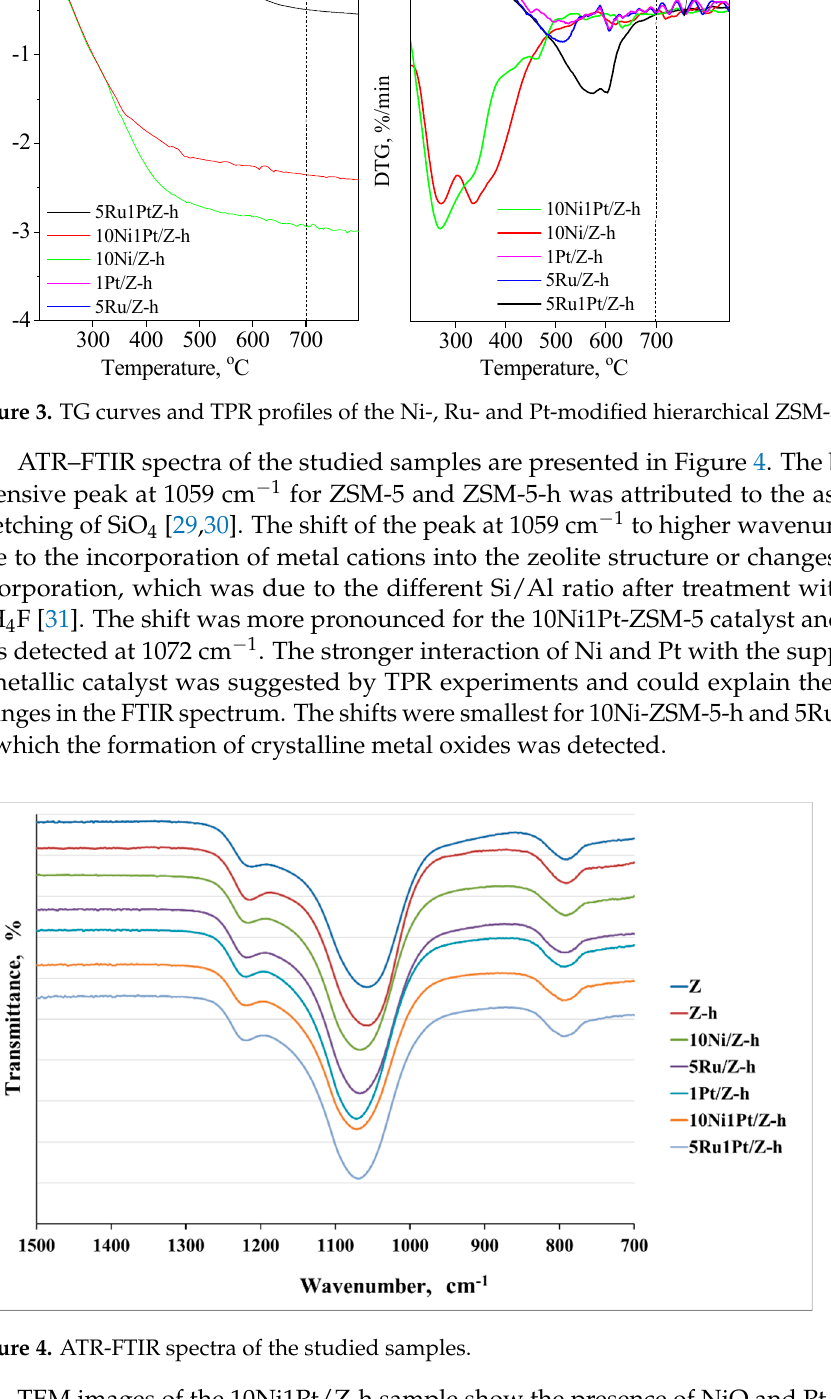
Figure 5. TEM images of 10Ni1Pt/Z-h ( A , B ) and 5Ru1Pt/Z-h ( C , D ) zeolites. 2.1.1. FTIR Spectra of Adsorbed Pyridine The acidic properties of selected catalysts were characterized by FTIR spectroscopy of adsorbed pyridine (Py) in order to compare their Brønsted and Lewis acidity [32]. The FTIR spectra of the investigated samples are presented in Figure 6. The 8a, 8b and 19b ring vibrations ( ν CCN ) of Py yielded adsorption bands in the 1700–1400 cm − 1 frequency region [33]. Py can be coordinated to Lewis acid sites (L-Py) or protonated on Brønsted acid centers (B-Py) of zeolites. B-Py showed a band pair at approximately 1545/1635 cm − 1 , whereas L-Py bands appeared at 1445–55 and 1610–23 cm − 1 frequencies. In zeolites Brønsted acidity stems from tetrahedrally coordinated aluminum species, where the negative charge of the framework is compensated by a proton, i.e., from bridged hy- droxyl groups (( ≡ Si–O) 3 ≡ Al–(OH)–Si ≡ ). Lewis acid sites are identi fi ed as Py coordinated